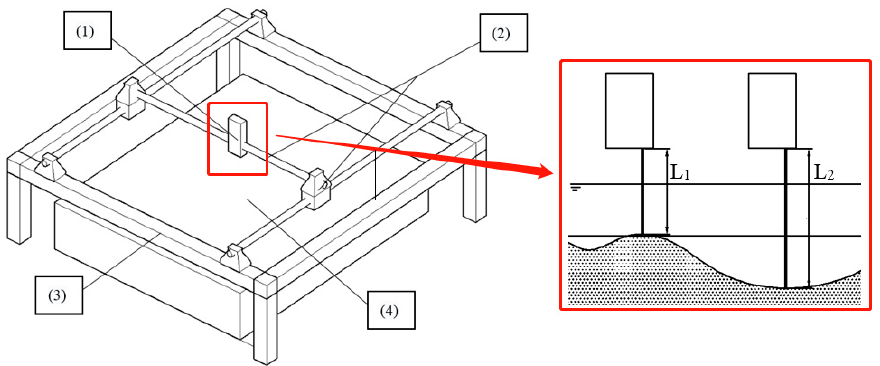
Figure 3. Measurement system: (1) Laser rangefinder; (2) optical axis and sliding block; (3) support; (4) experimental tank.